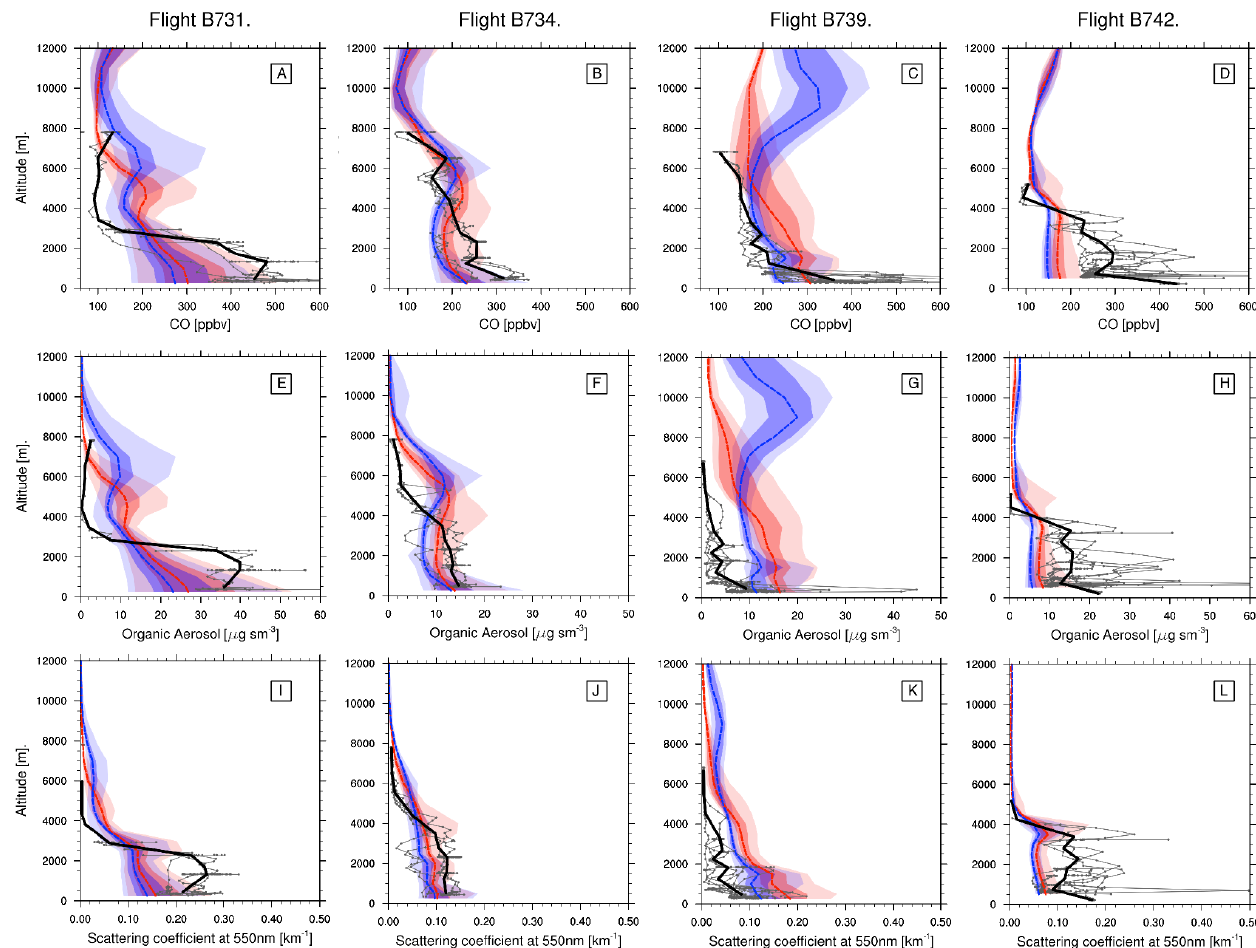
Figure 8. Vertical profiles of CO (ppbv), POM (µgsm − 3 ) and b scat at 550nm (km − 1 ). ( a , e and i ) from flight B731 (14 September 2012); ( b , f and j ) from flight B734 (18 September); ( c , g and k ) from flight B739 (23 September); and ( d , h and l ) from flight B742 (27 September). The red dashed lines show the median from the modified emissions scenario, with the strong red shaded region showing the interquartile range and the faded region the fifth to the ninety-fifth percentile range. The blue lines and shaded regions are for the standard 3BEM emissions scenario; a solid black line shows median line of profiles conducted by flights; the fine grey lines show flight measurements averaged over every